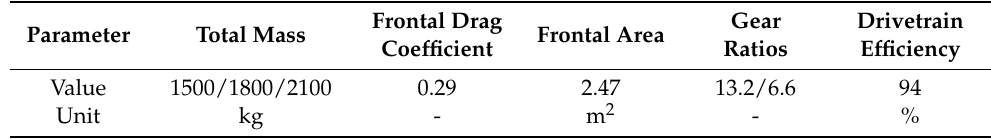
Table 3. Vehicle parameters for simulation.